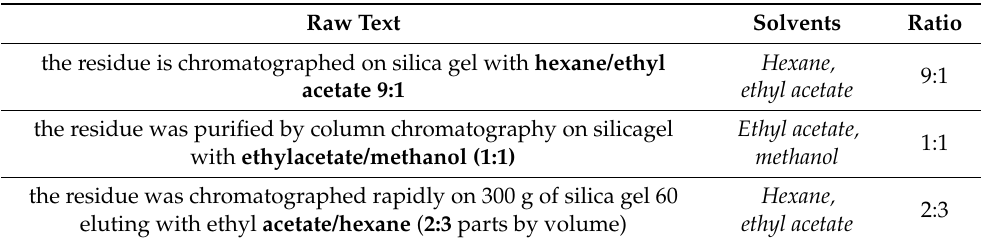
Table 1. An example of the extracted data from the purification step within the synthesis instruction. Regions in bold text draw attention to the exact parts that were extracted. Raw Text Solvents